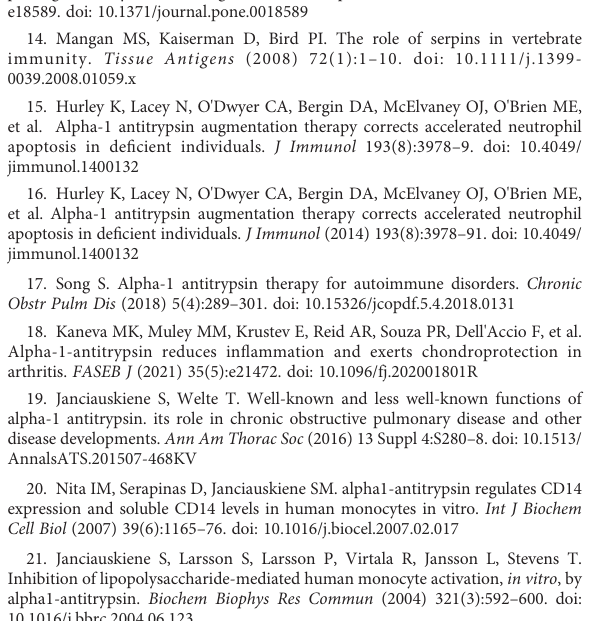
MassspectrometryanalysisdataofscreeningSERPINA1interactingproteins.